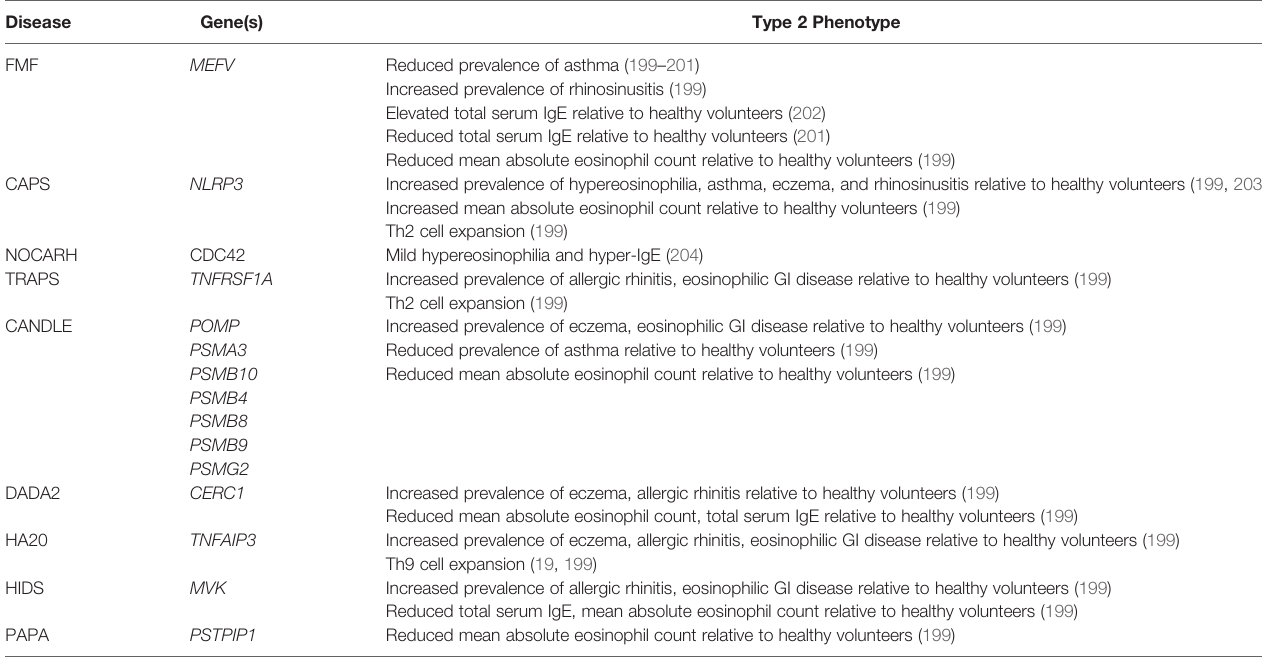
TABLE 1 | Associations of monogenic autoin fl ammatory diseases with type 2 clinical and immunological phenotypes.